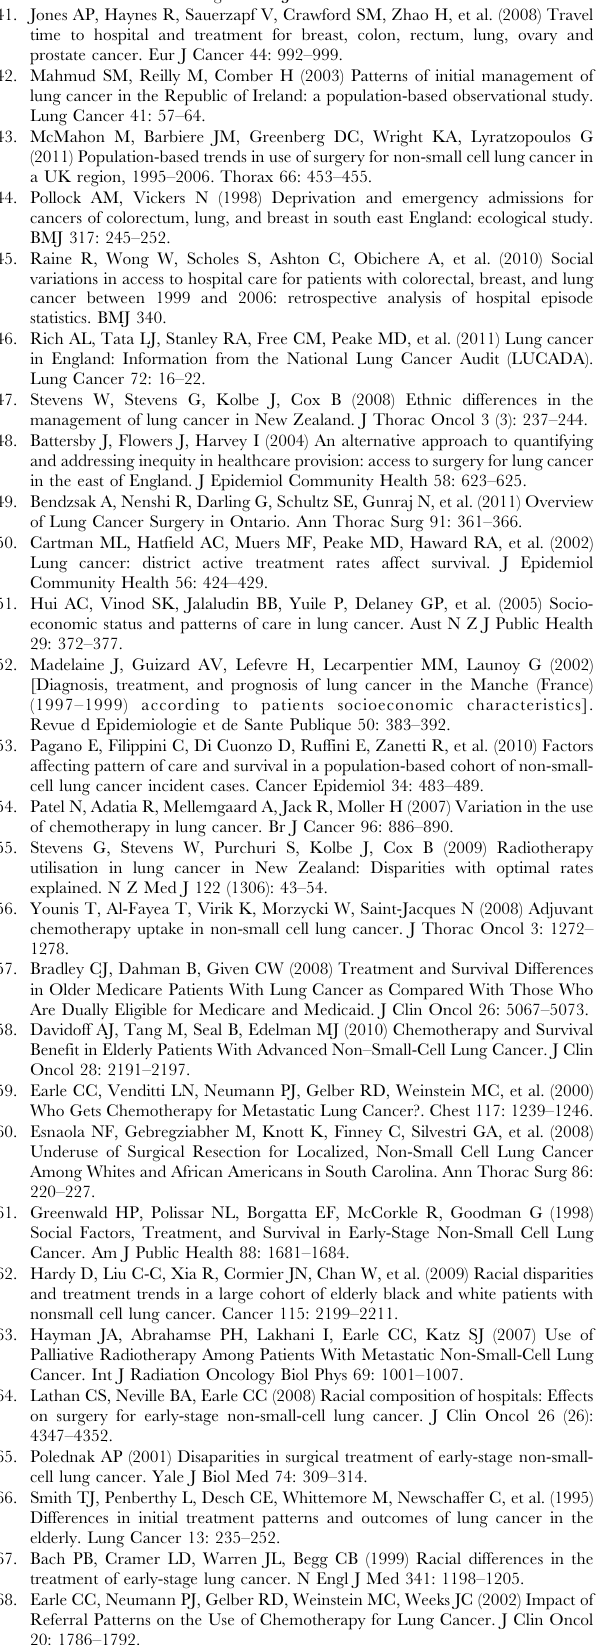
Referral Patterns on the Use of Chemotherapy for Lung Cancer. J Clin Oncol 20: